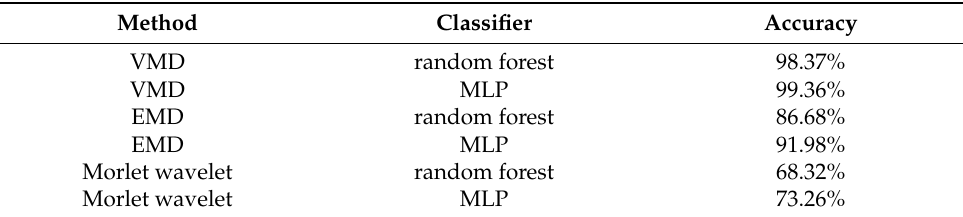
Table 3. Several feature extraction methods and classification effects of the